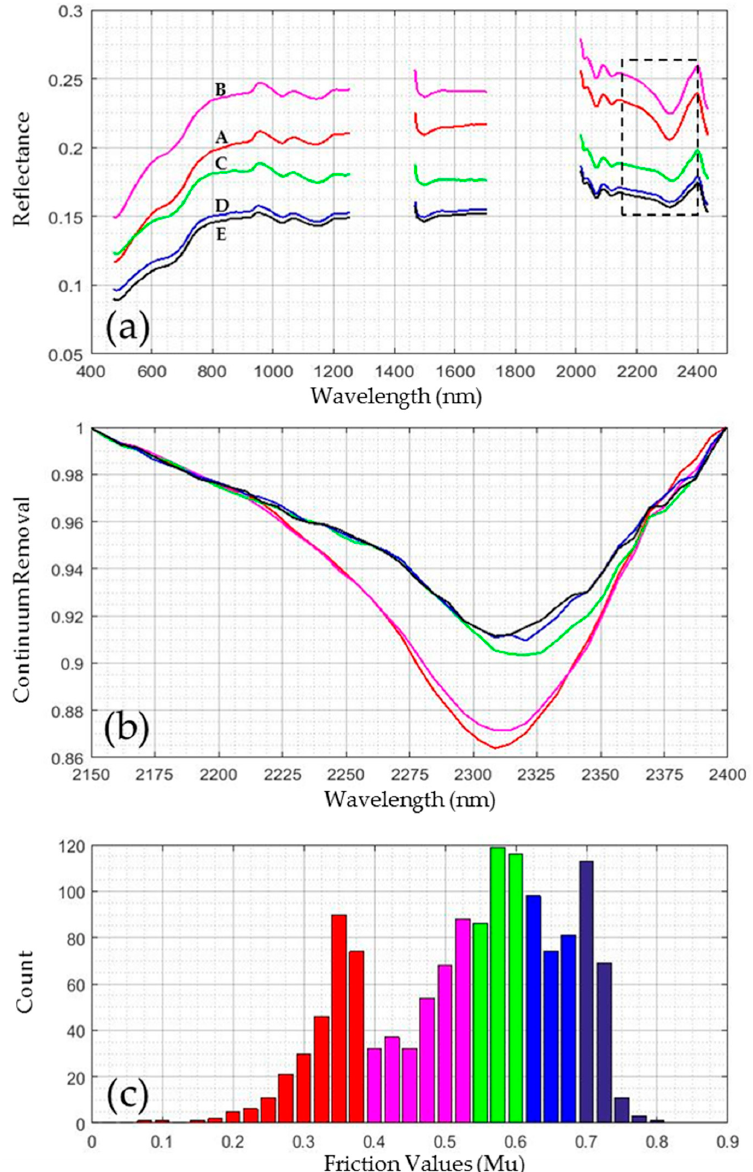
Figure 2. Data exploration plots colored by group: ( a ) Average spectra by friction group with labeled group ranks and CR range in dotted box; ( b ) CR average spectra (2150–2400 nm) by friction group rank; ( c ) Histogram of friction values colored by corresponding group rank (see Table 2 for group definition).